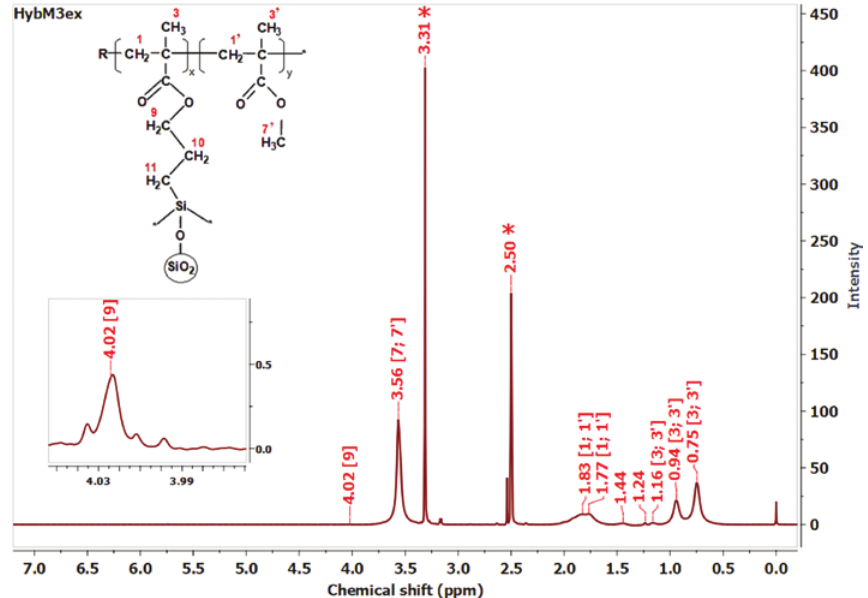
nanocomposite in DMSO-d 2